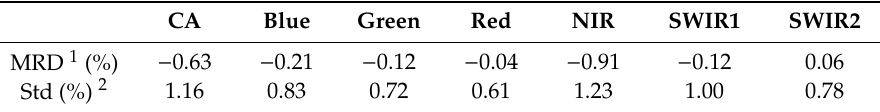
Table 7. Mean reflectance di ff erences for the combined NEON Sites. CA Blue Green Red NIR SWIR1